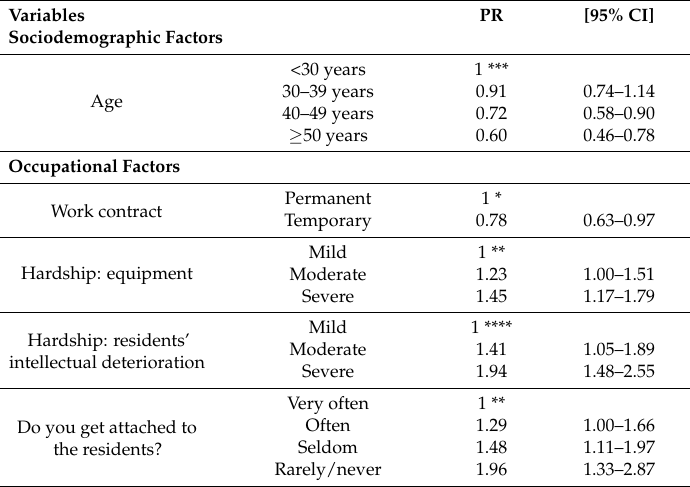
Table 2. Significant associations between nursing assistants’ intention to leave work with the elderly and sociodemographic, occupational, psychosocial and medical factors on intermediate multivariate